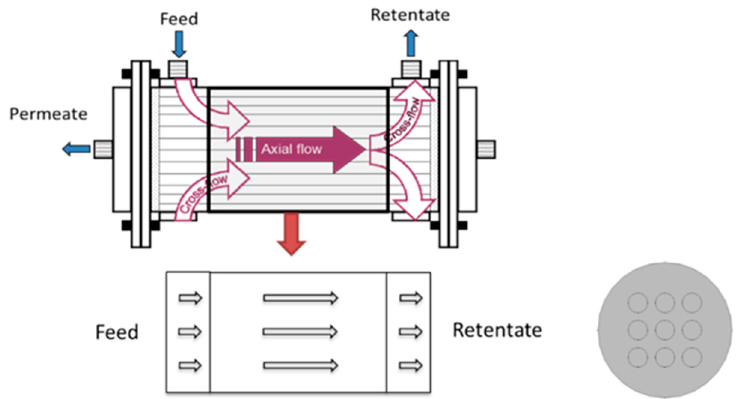
Figure 1. Typical hollow fiber membrane module and flow regions. The domain used for the simulations is indicated by the thick black rectangle in the upper image and the middle rectangle in the lower left image. The lower right image illustrates the module cross-section.